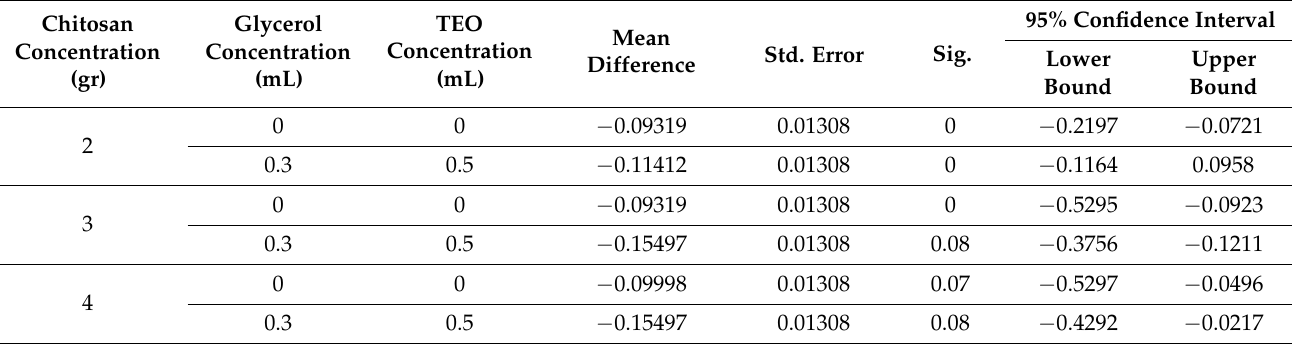
Table 4. % elongation for all samples using ANOVA method for difference samples.